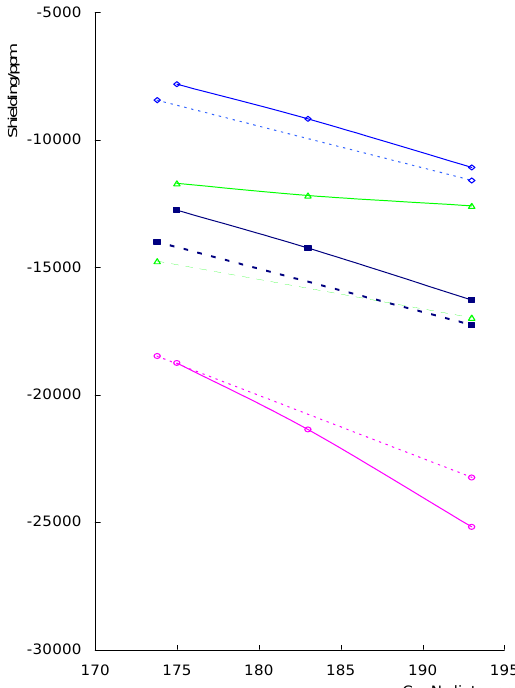
Figure 1. Variation of shielding with change in Co-N distance for a set of dithiocarbamato complexes for which the CoNO geometry is relaxed (solid lines) and for Schiff base complexes with CoNO 120° and an NO distance of 1.16Å (dotted lines) ■ isotropic shielding, ○ σ